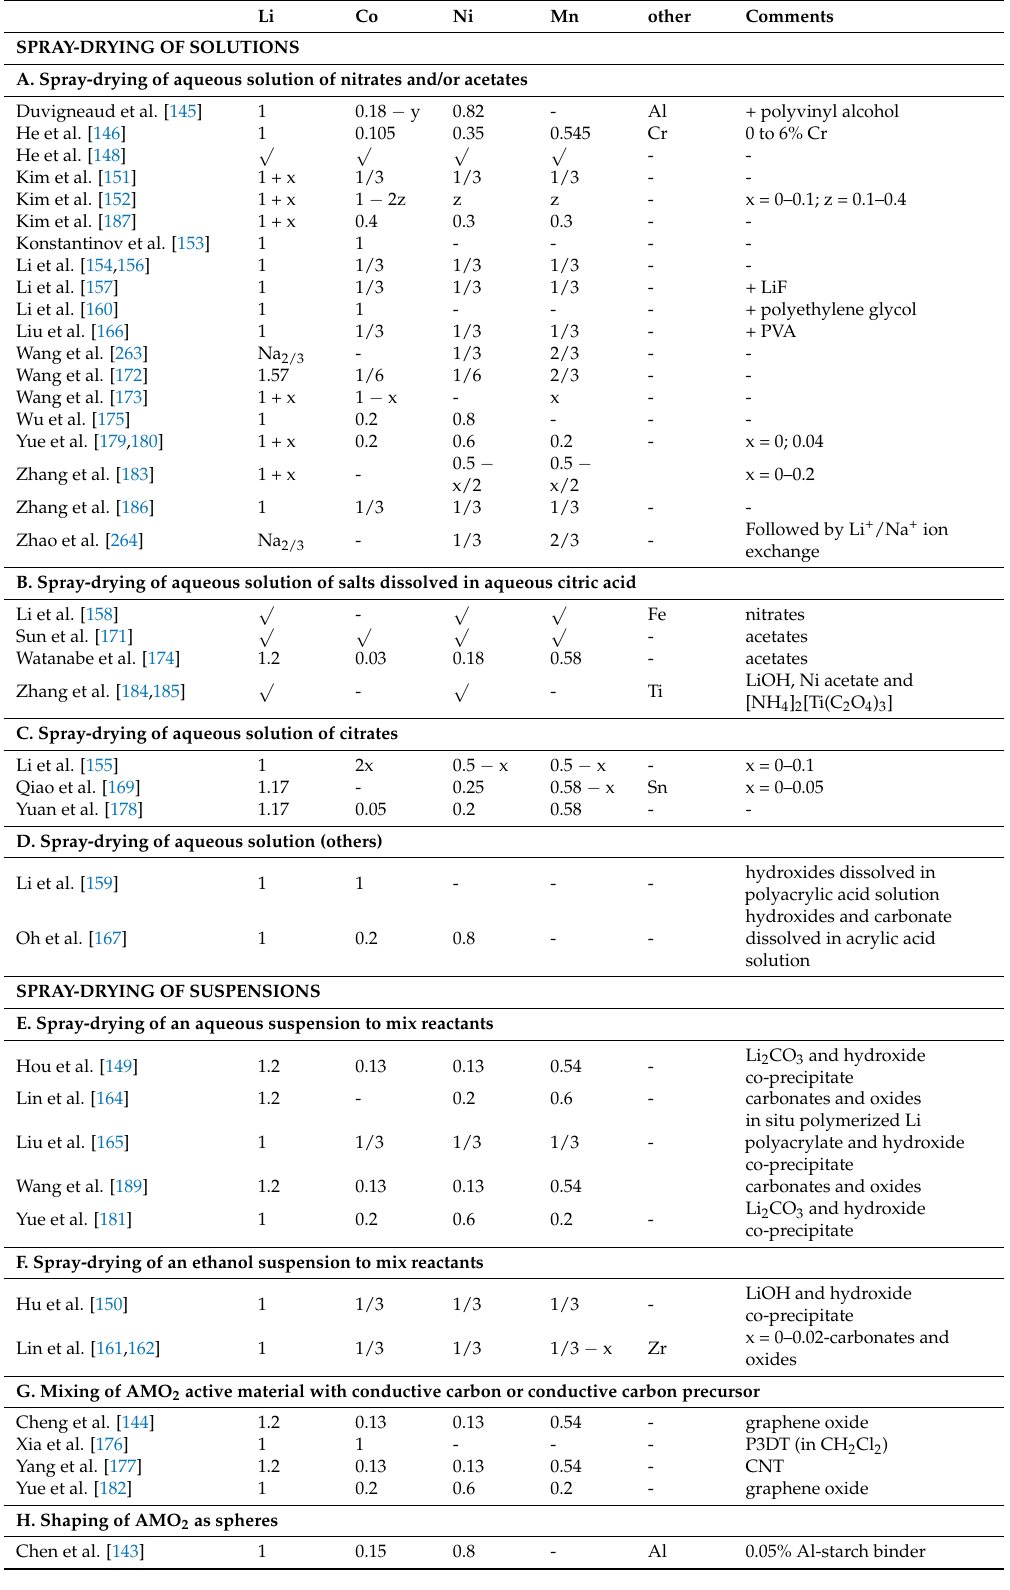
Table 3. Spray-drying for layered oxides AMO 2 (A = Li + , Na + ; M = one/several of Li, Ni, Mn, Co, Al, . . . ). Li Co Ni Mn